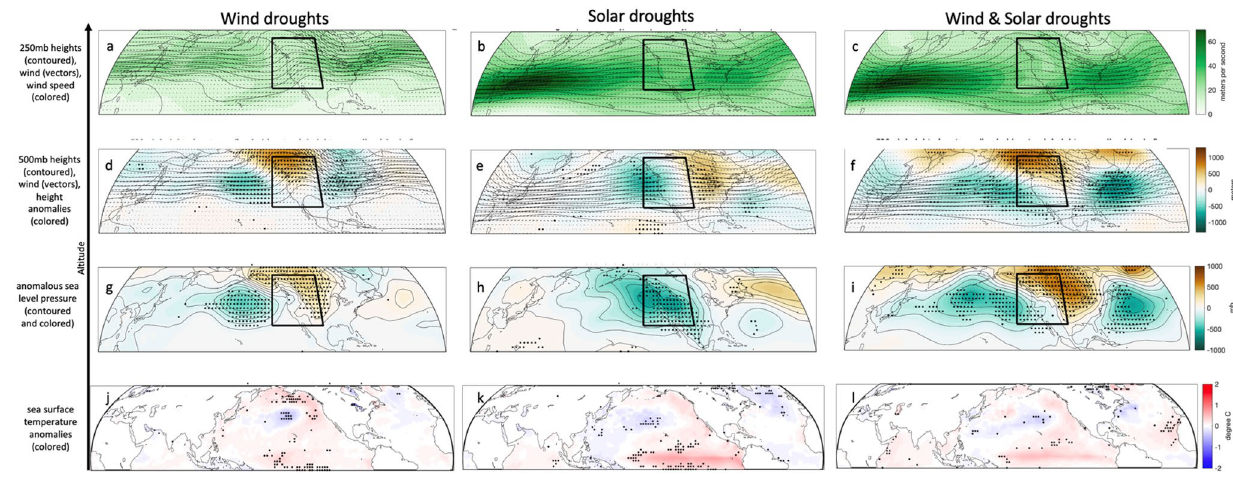
value for that week of the year and the stippling shows where at least 28 of the 37 weeks (> 75%) showed anomalies of the same sign. Figures S10–S12 show 500 mb height plots for each individual drought event and Figs. S13–S15 show sea surface temperature anomaly plots for each individual drought event. Figures S17 and S20 shows the sensitivity of this plot to defining droughts using either the 0.5th percentile (Fig. S17) or the 2nd percentile (Fig. S20)